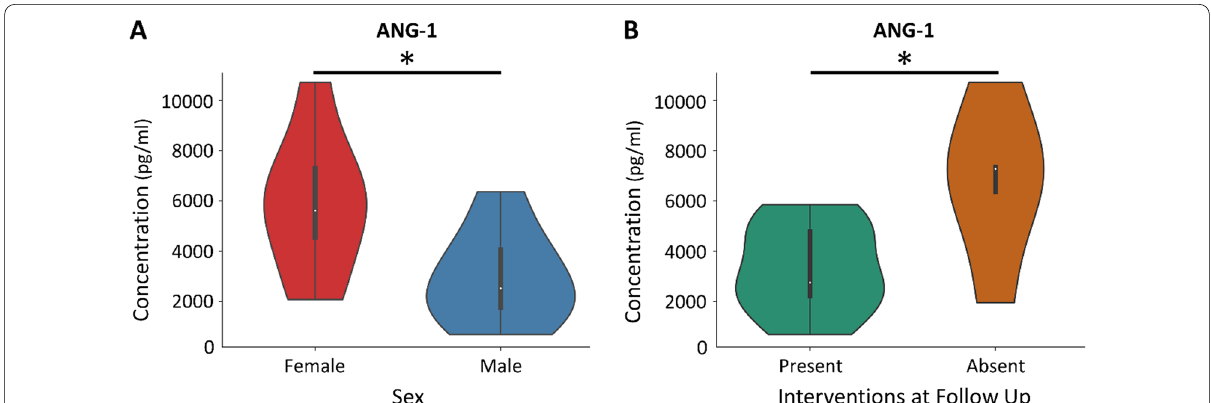
Fig. 4 Violin plots demonstrating ANG-1 distribution in Long-COVID patients relative to sex and interventions at follow-up. A A violin plot demonstrating significantly elevated concentration of blood ANG-1 in Long-COVID female outpatients (*P < 0.05). B A violin plot demonstrating significantly elevated concentration of blood ANG-1 in Long-COVID outpatients that had no interventions at follow-up (*P < 0.05). Given the limited number of patients within this subgroup, the data was not corrected for multiple comparisons and should be considered